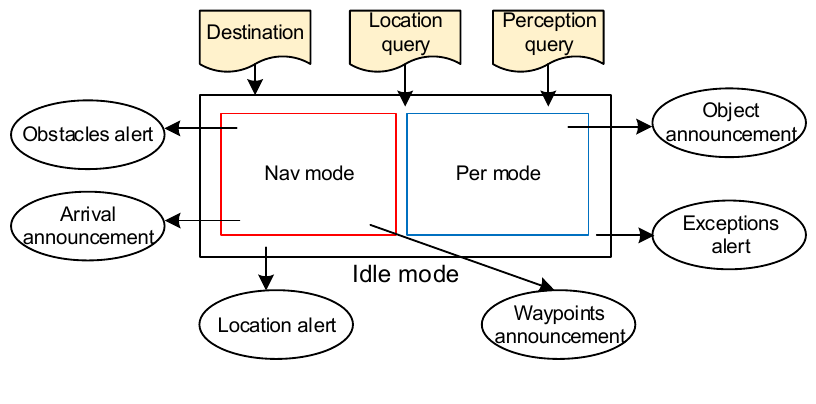
Figure 9. HMI operational mode.